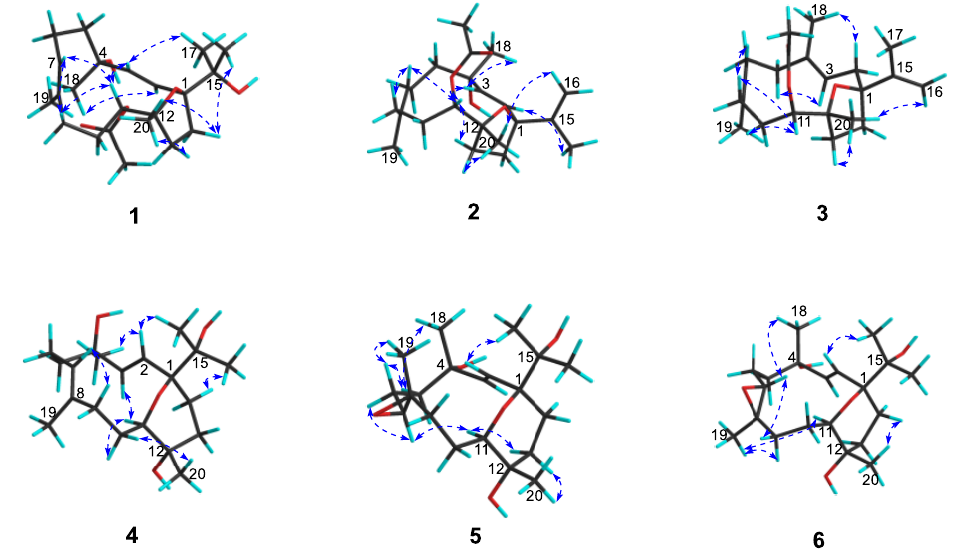
Figure 4. Selected key ROESY correlations for compounds 1 – 6 .